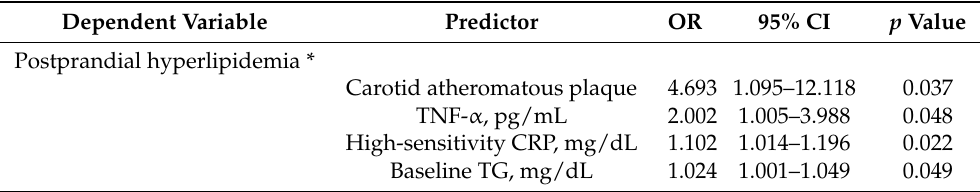
Table 6. Logistic regression model for factors associated with postprandial hyperlipidemia in patients with RA. Dependent Variable Predictor OR 95% CI p Value Postprandial hyperlipidemia * Carotid atheromatous plaque 4.693 1.095–12.118 High-sensitivity CRP,